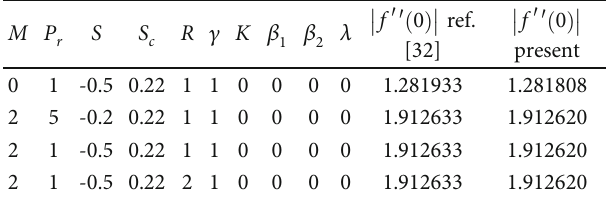
Table 2: Values of skin friction coe ffi cient in comparison between current study and previous study ref. [32].